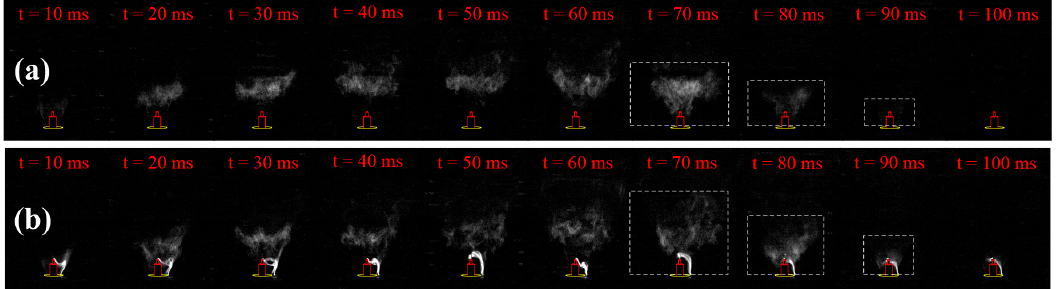
Figure 16. ( a ) The dynamic process of CH distribution in pulsating air flow mode; ( b ) The dynamic process of CH distribution in plasma-pulsating air flow mode (sample rate: 1000 fps, exposure time: 1 ms).